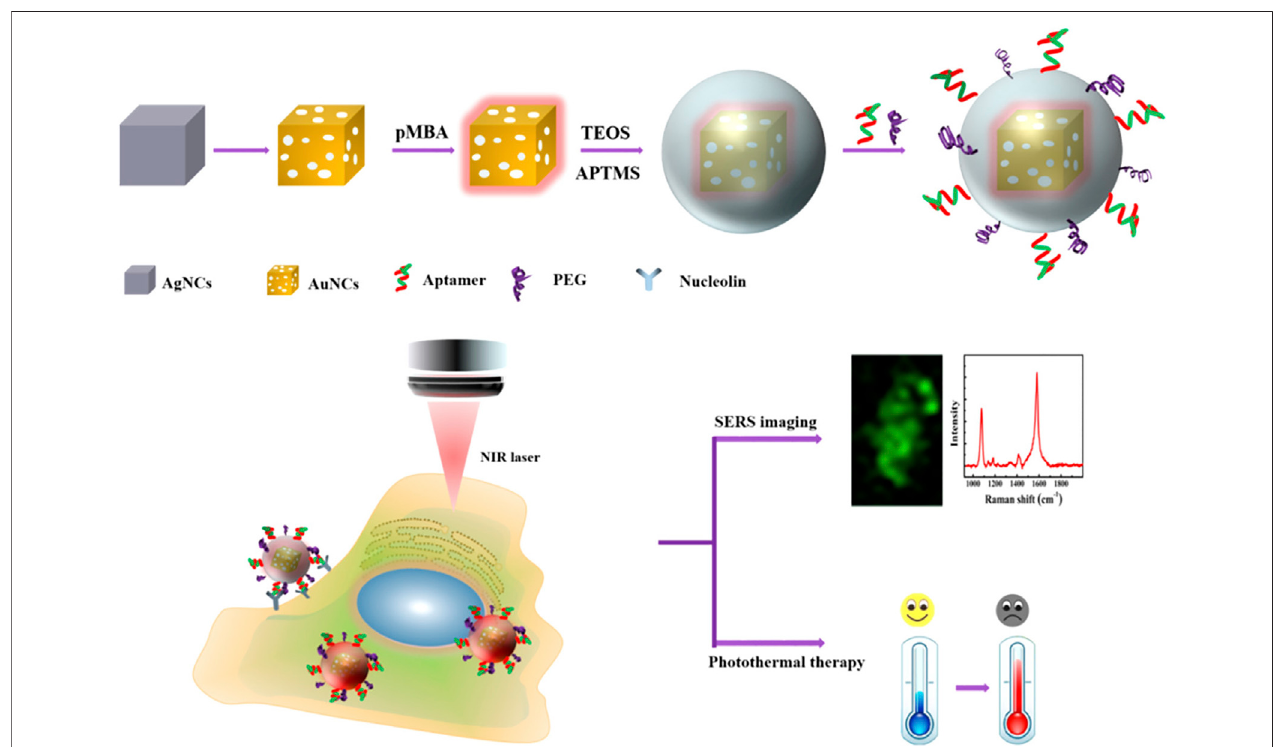
FIGURE 2 | Schematic diagram of cellular SERS imaging and photothermal therapy (Wen et al., 2019)